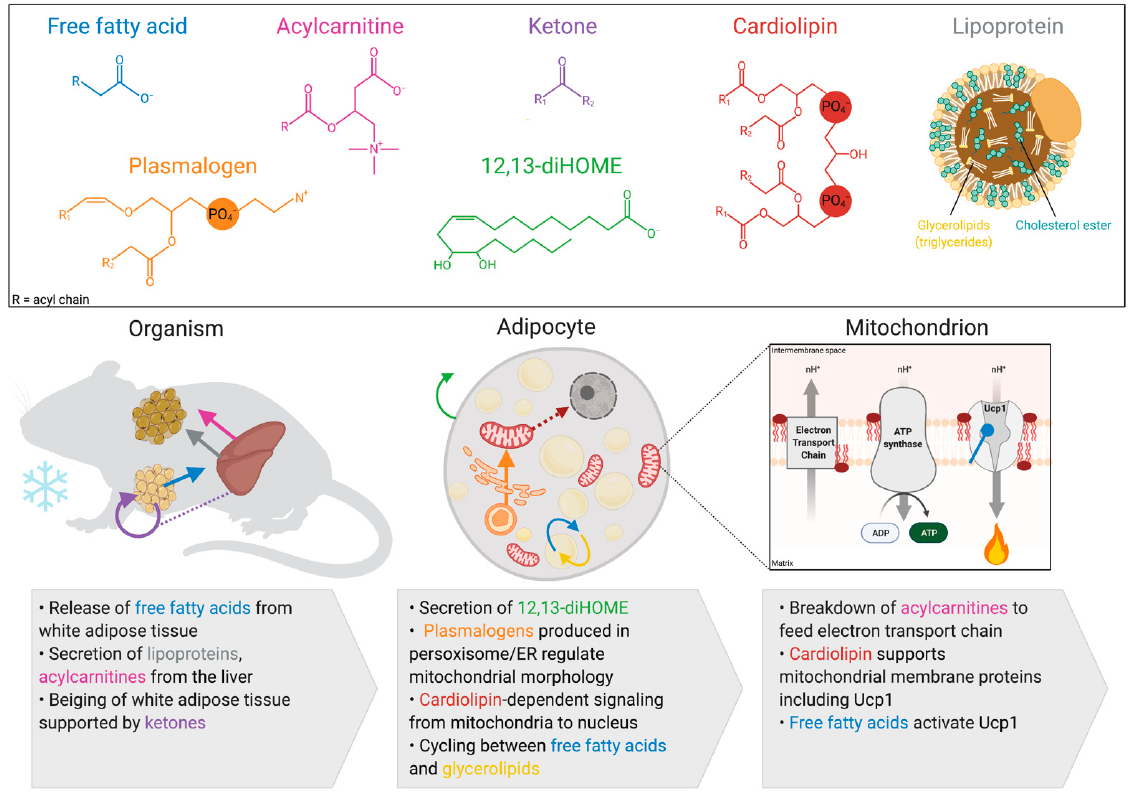
Figure 1. Lipids that regulate mitochondria to support thermogenesis in brown and beige adipocyte. Thermogenesis involves multi-organ orchestration of lipid processing. White adipocyte lipolysis releases circulating free fatty acids (blue arrow) which are taken up by the liver and thermogenic adipose tissue. Once in the liver, free fatty acids can be processed into lipoproteins (grey arrow) or acylcarnitines (pink arrow), which are released into the circulation to be taken up by brown adipose tissue. Some lipids are produced directly in the brown or beige adipocyte including 12,13-diHOME (green arrow), ketones (purple arrow), plasmalogens (orange arrow), and cardiolipin (red arrow). Many of these lipids have numerous roles including cardiolipin, which is a component of mitochondrial membranes, stabilizes uncoupling protein 1 (UCP1), and signals to the nucleus regulating transcription. Created with